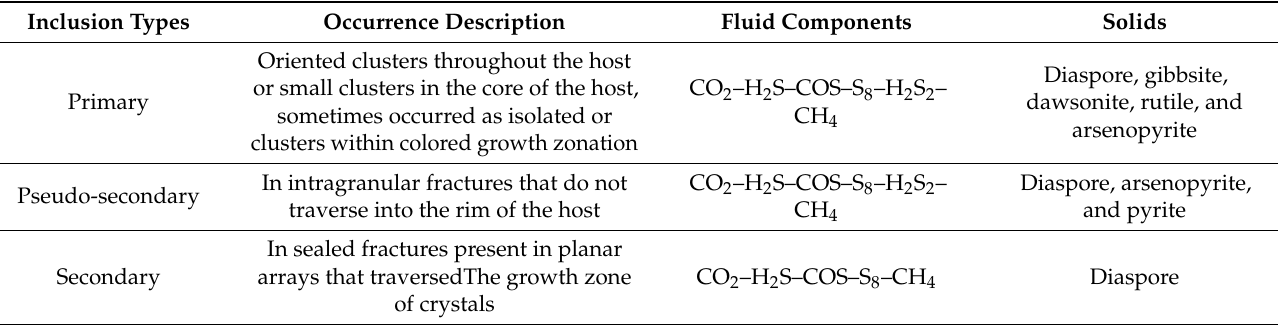
Figure 4. Photomicrographs of H 2 S 2 –bearing fluid inclusions. These fluid inclusions sometimes contain rutile crystals ( a , c ) and diaspore crystals ( a – d ): L—liquid carbonic phase. Table 1. Summary of occurrences and components of various types of fluid inclusion in Yuanjiang rubies.